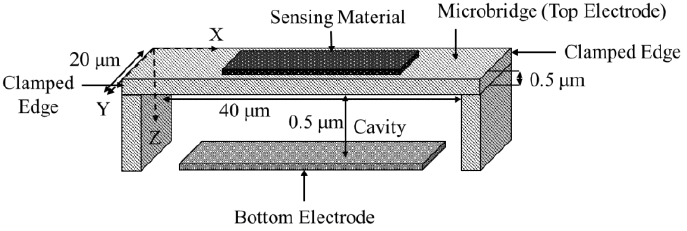
Figure 10. Schematic view of a microbridge structure (image not to scale).